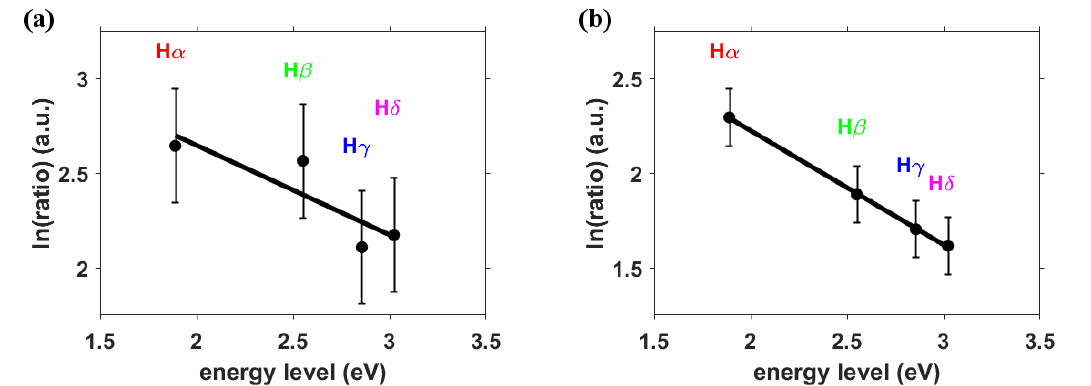
Figure 11. Boltzmann plot from line-of-sight data at 4.8-mm slit height. ( a ) T = 26.5 kK, time delay 1.5 µ s (Figure 2). ( b ) T = 19.3 kK, time delay 3.25 µ s (Figure